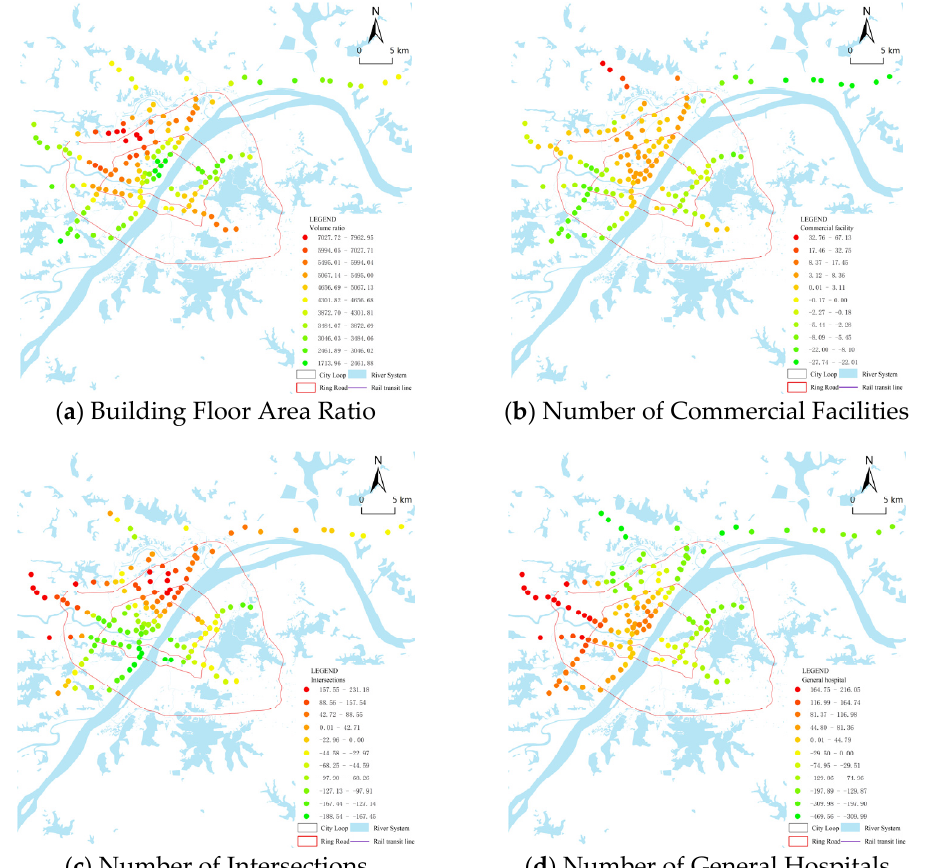
Figure 5. Spatial variation in the impact of different built environment elements on metro ridership of the elderly.